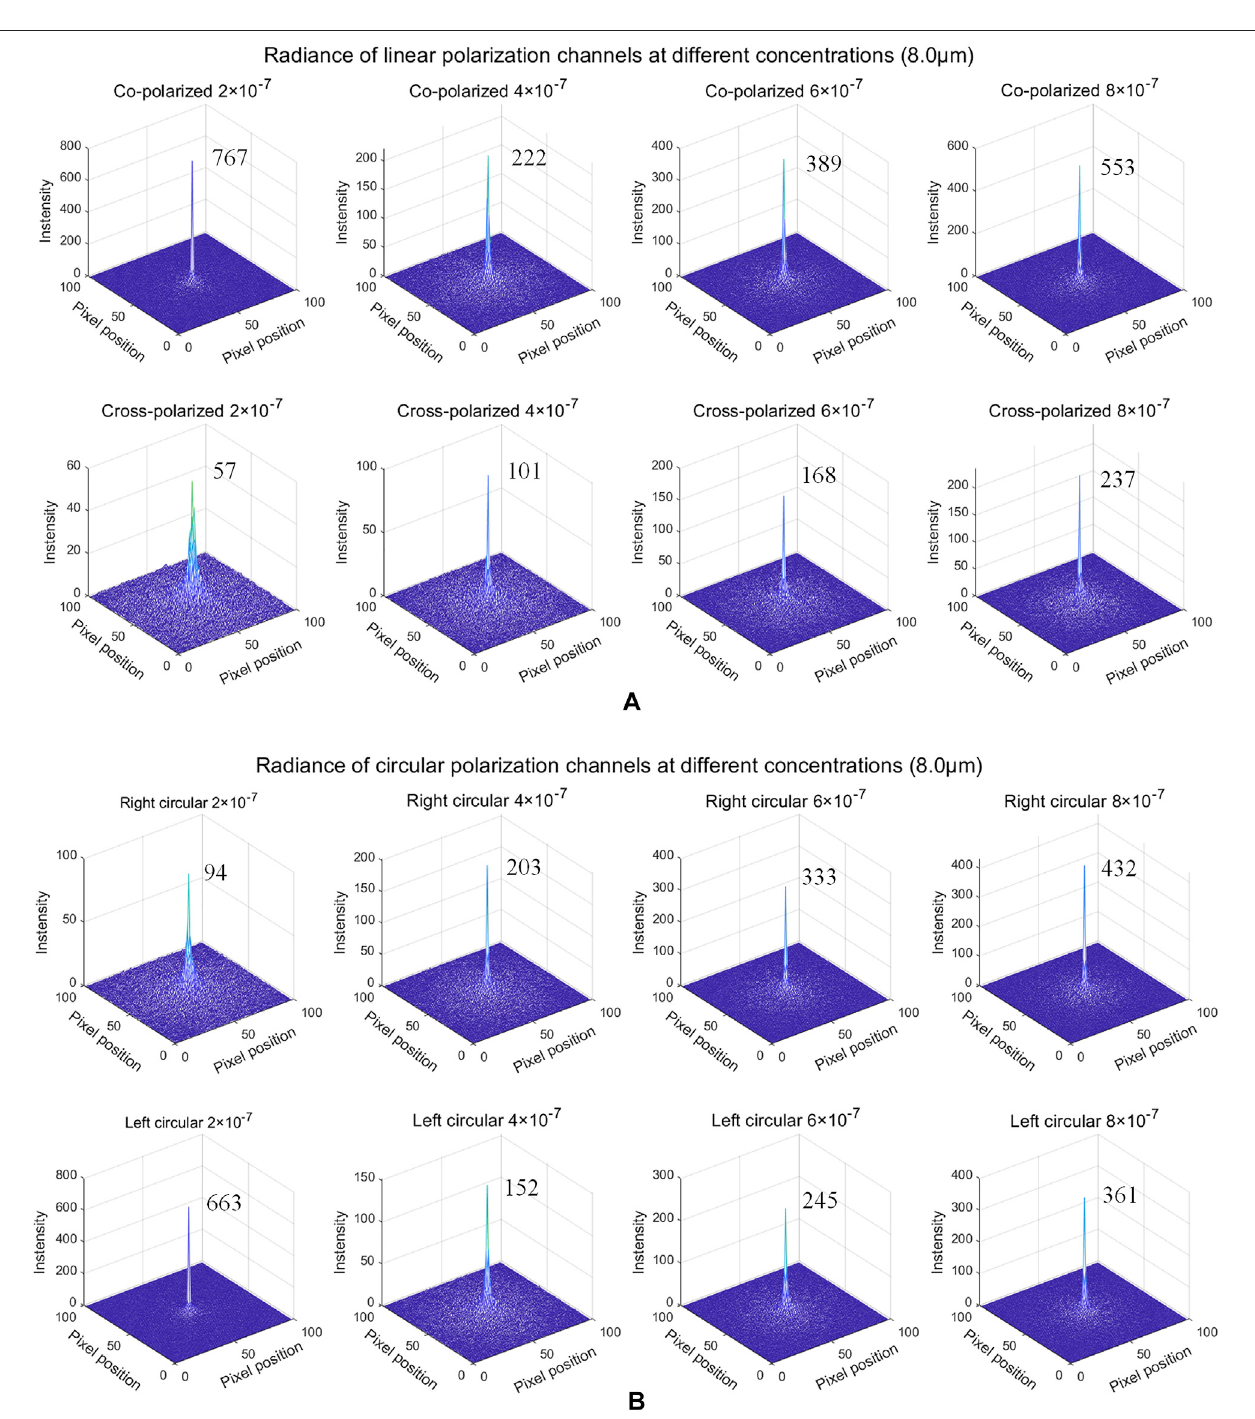
FIGURE 3 | Radiance of polarization channels at different concentrations in the medium with large-sized particles (8.0 μ m). (A) co-polarized and cross-polarized radiance, (B) right circular and left circular polarized radiance.